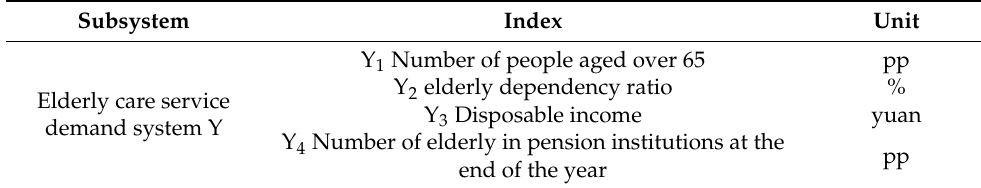
Table 2. Indexes of elderly care service demand